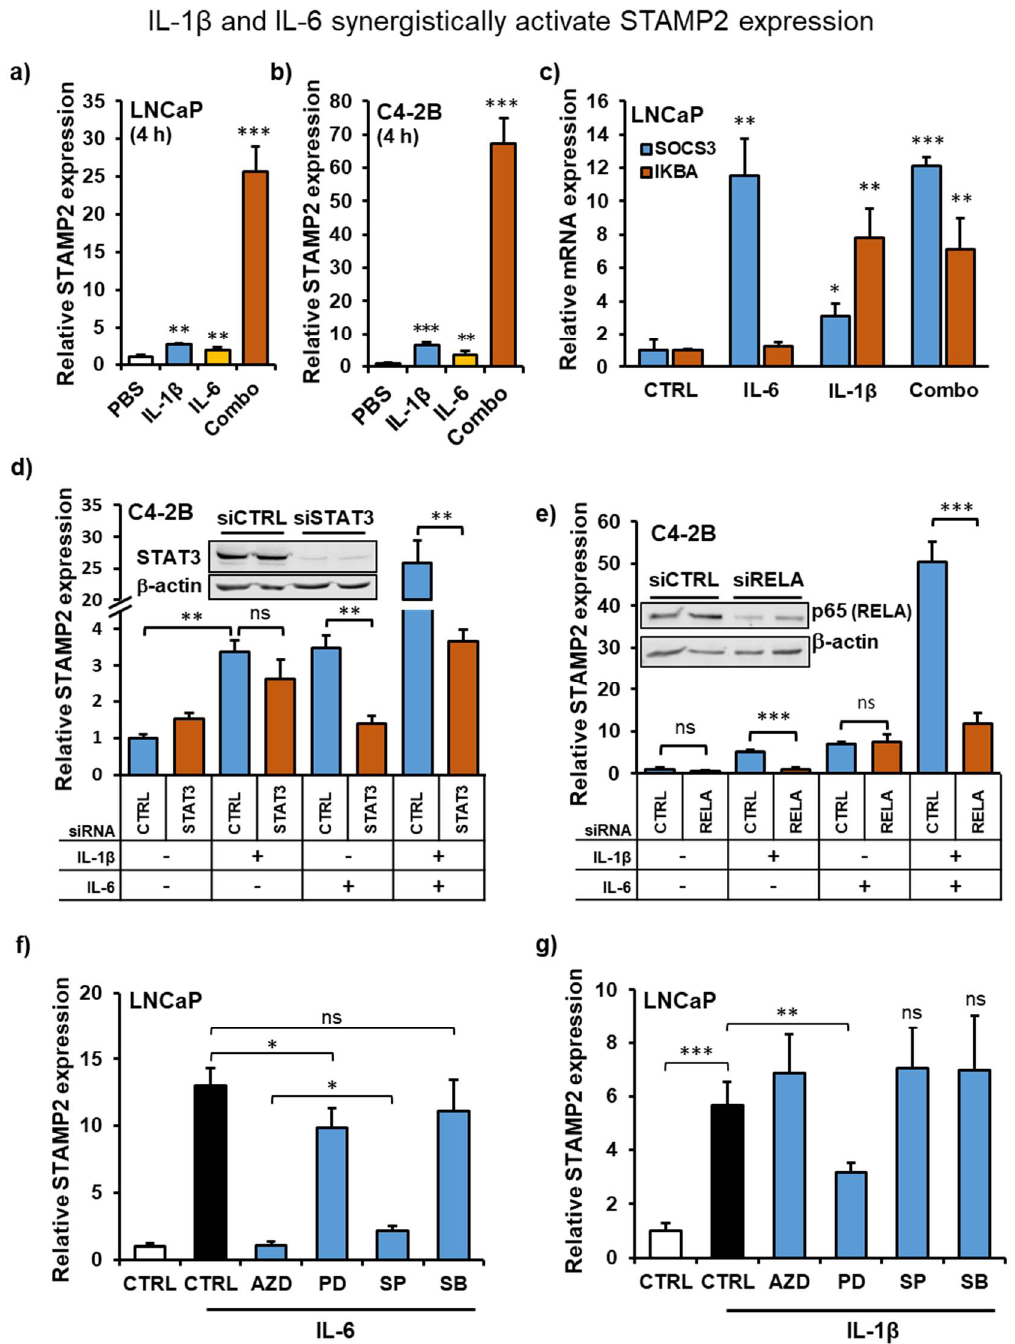
Figure 4. IL-1 β and IL-6 synergistically activate STAMP2 expression. ( a – c ) LNCaP cells ( a , c ) and C4-2B cells ( b ) were serum-starved and then induced with IL-6, IL-1 β , or their combination for 16 h. Total RNA was harvested and expression of the indicated genes was determined by qRT-PCR analysis. Statistics shown by asterisks above the columns are relative to respective PBS or CTRL treatments. ( d , e ) C4-2B cells were transfected with siRNAs against STAT3 ( d ) or p65 (RELA) ( e ) for 48 h, followed by treatment with IL-6, IL-1 β , or their combination for 16 h. The cells were harvested for qRT-PCR and Western blot analysis. The insets show the efficiency of knockdowns. ( f , g ) LNCaP cells were pretreated with indicated kinase inhibitors (0.5 µ M AZD1480 (AZD), 50 µ M PD98059 (PD), 10 µ M SP600125 (SP), or 20 µ M SB203580 (SB)) in a serum-free medium for 2 h prior to induction with 30 ng/mL IL-6 (for 2.5 h) ( f ) or 20 ng/mL IL-1β (for 4 h) ( g ). Total RNA was harvested and subjected to qRT-PCR analysis. Statistics shown by asterisks above the columns are relative to the control treatments. * p < 0.05, ** p < 0.01, *** p < 0.001.